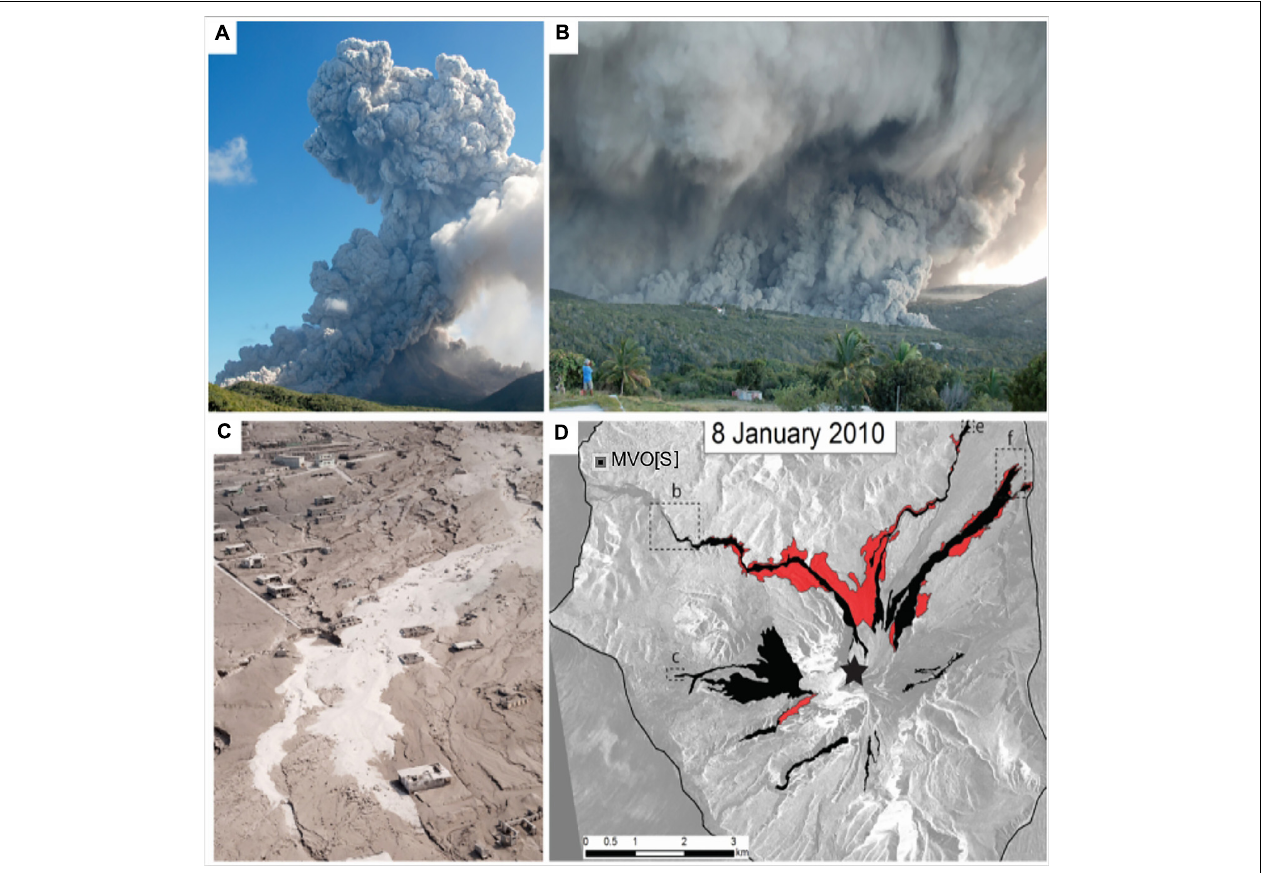
FIGURE 1 | Three images and a pyroclastic density current (PDC) flow map of the January 8, 2010 explosion of the Soufrière Hills Volcano. (A) Explosion plume after 30 s, with ground-hugging PDCs moving predominantly to the NW (right in photo) and to the NE (left). (B) PDC moving down the Belham Valley to the NW. (C) PDC deposits in Plymouth, 4 km to the west. (D) Map showing the extent of the high-particle concentration PDCs (black) and low-particle concentration PDCs (red). The crater location is marked on panel (D) by a star and the locations of photographs (b) and (c) are indicated by broken line rectangles [photos (e) and (f) photos are not here]. For the counterfactual discussion of hazard and risk at MVO[S], due to a hypothetical runaway explosion down the Belham Valley, note in panel (b) the pyroclastic flow progressing down the valley, 5 km from the volcano; MVO[S] was about 6.5 km from the volcano. This event and its runout distance are used to calibrate the MOLASSES flow model (see text). [Figure reproduced with permission from Figure 5.5 of Cole et al. (2014), courtesy of the authors and the Geological Society of